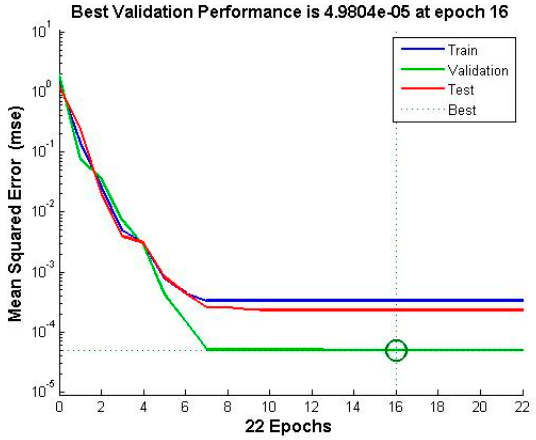
Figure 11. Mean square error curve of the BP artificial neural network based on genetic algorithms.